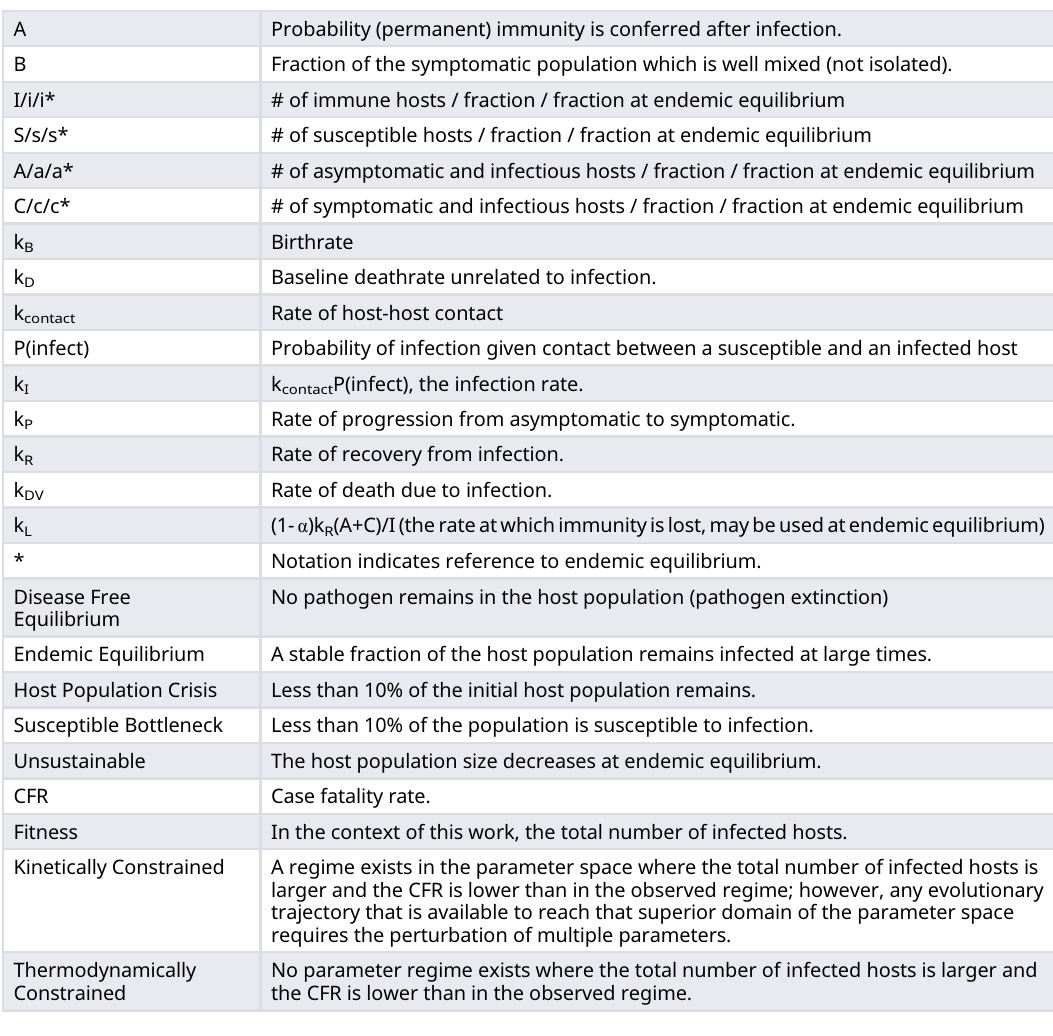
Table 1. Model parameters and key